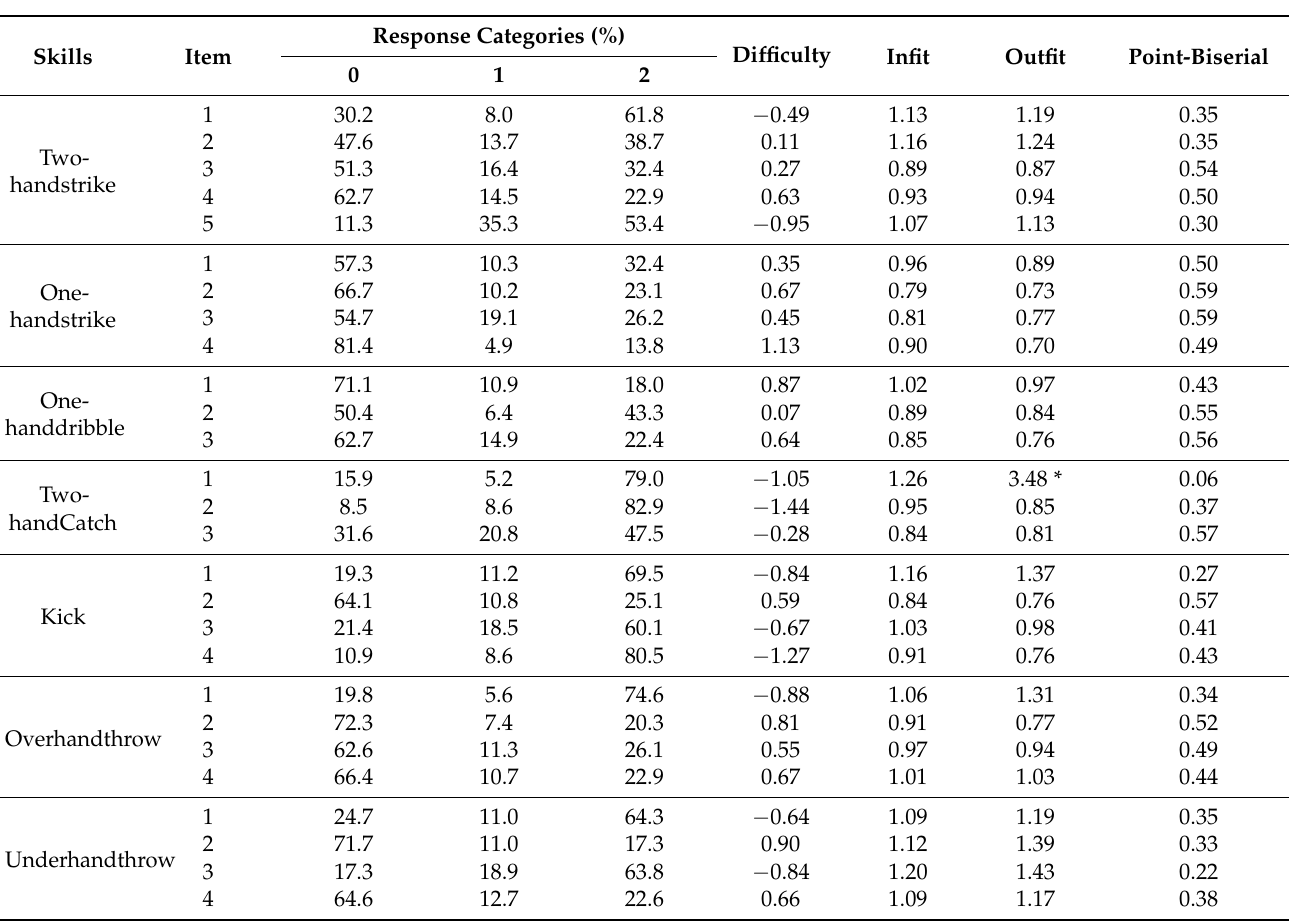
Table 3. Percentage of Response, Item Difficulty, Infit and Outfit Indexes, Point-Biserial Correlations with the Ball Skills Scale